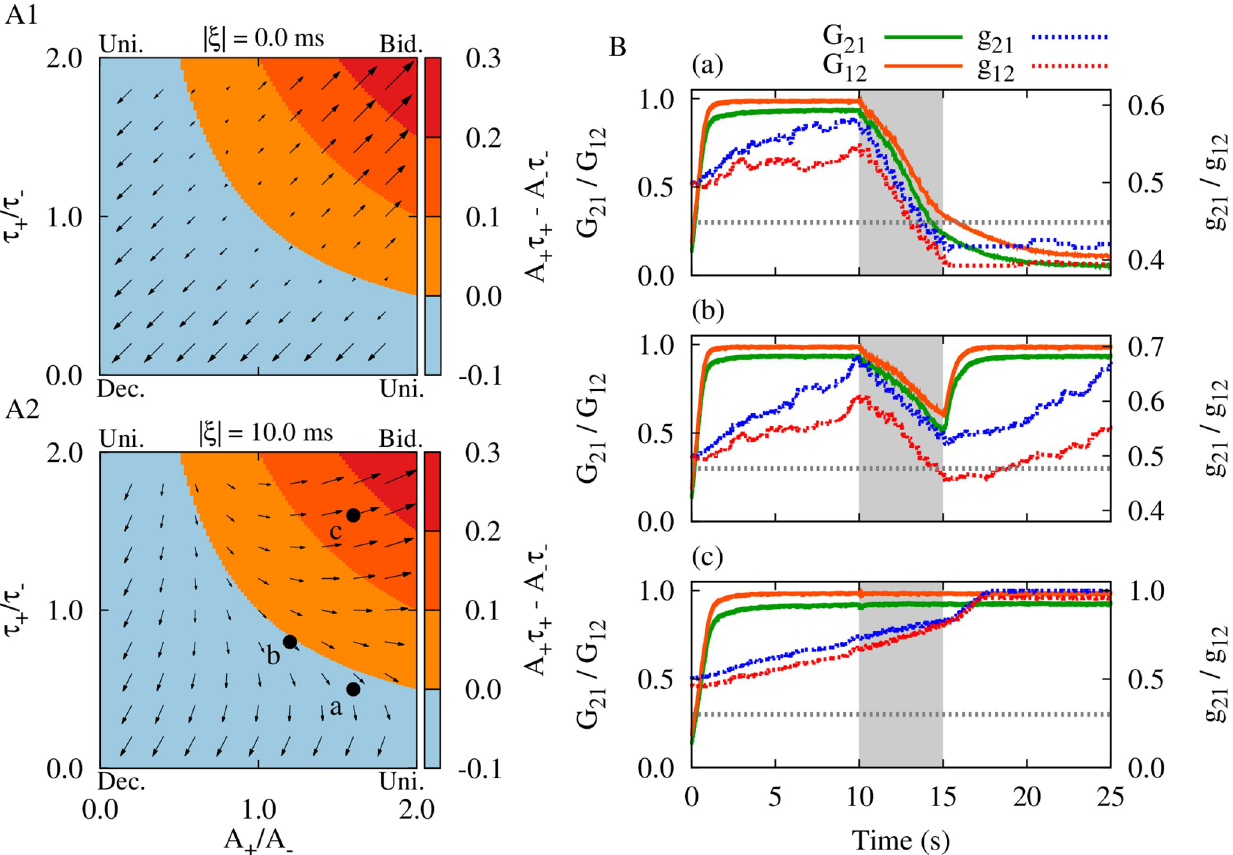
Fig 5. Stimulation-induced decoupling depends on the STDP parameters. ( A1,A2 ) Colors show the imbalance between STDP potentiation and depression rates, and time constants for | ξ | = 0.0 ms (A1) and | ξ | = 10.0 ms (A2). A − = 0.005 and τ − = 20 ms were fixed and A + and τ + were varied. Arrows show the direction of synaptic change calculated theoretically based on Eq (5) where each corner of A1 and A2 labeled as the emergent synaptic structure between two neurons marked as bidirectional (right top), unidirectional (left top and right bottom) and decoupled (left bottom) states. Point a: ( A + / A − , τ + / τ − ) = (1.6, 0.5) shows parameters used for stimulation in Figs 3 and 4. Parameters shown in points b: (1.2, 0.8) and c: (1.6, 1.6) were used to provide a comparison. ( B ) Time course of the synaptic strengths in the two-neuron motif ( g 21 / g 12 ) and inter-population mean coupling between two modules in the network ( G 21 / G 12 ) are shown for STDP parameters represented by points a-c in A2, respectively. The highlighted area indicates the stimulation epoch. The horizontal dotted lines (grey) roughly show the threshold ( G th � 0.3) where the synaptic strengths must cross to obtain a stable loosely connected network structure. Stimulation parameters were ν = 33.3 Hz and Δ t = 5